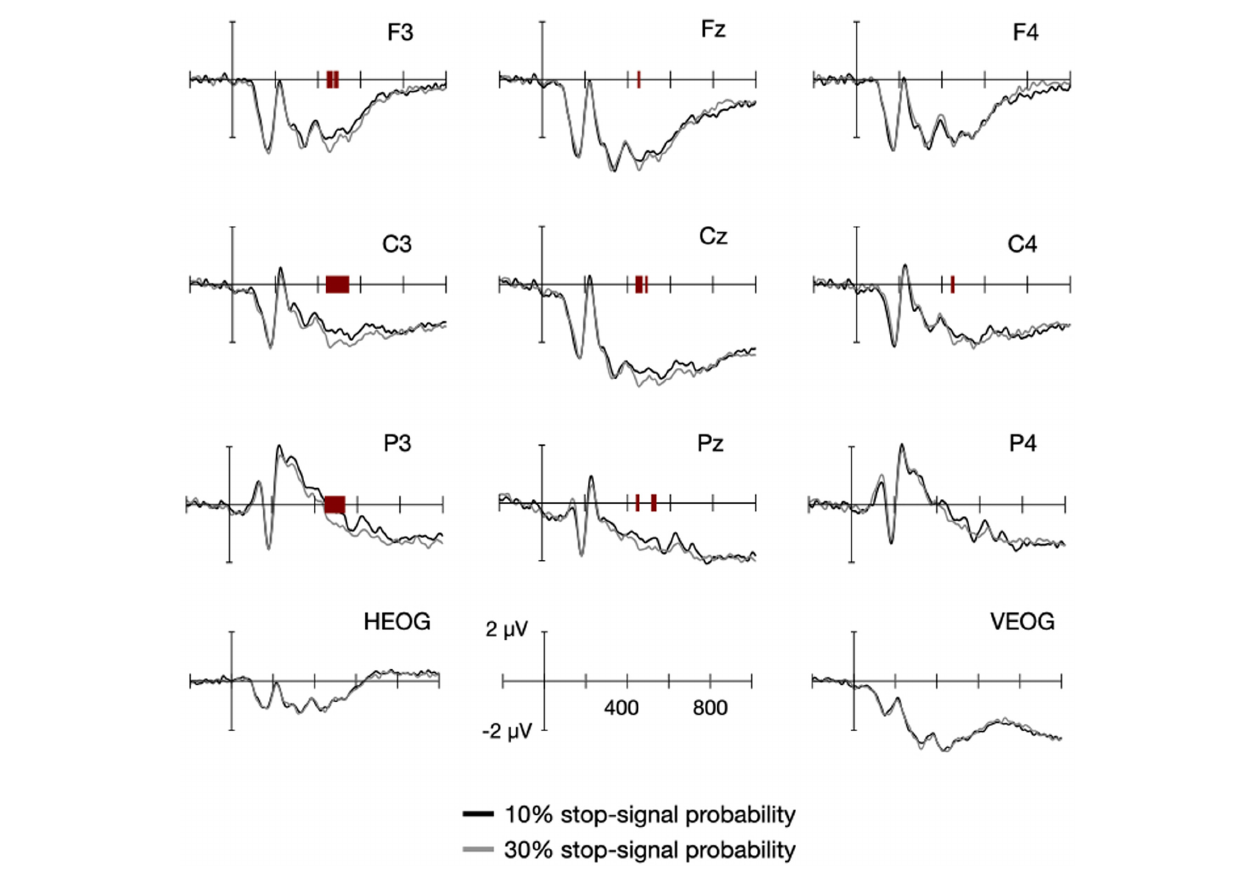
FIGURE 3 | Event-related potentials (ERPs) between the high- and low probability conditions. ERPs were locked to the onset of fixation for the nine electrodes around Cz. The black and gray lines are associated with the low- and high probability conditions, respectively. The red bars at the x-axis indicate the statistically significant difference between the two conditions of the corresponding time